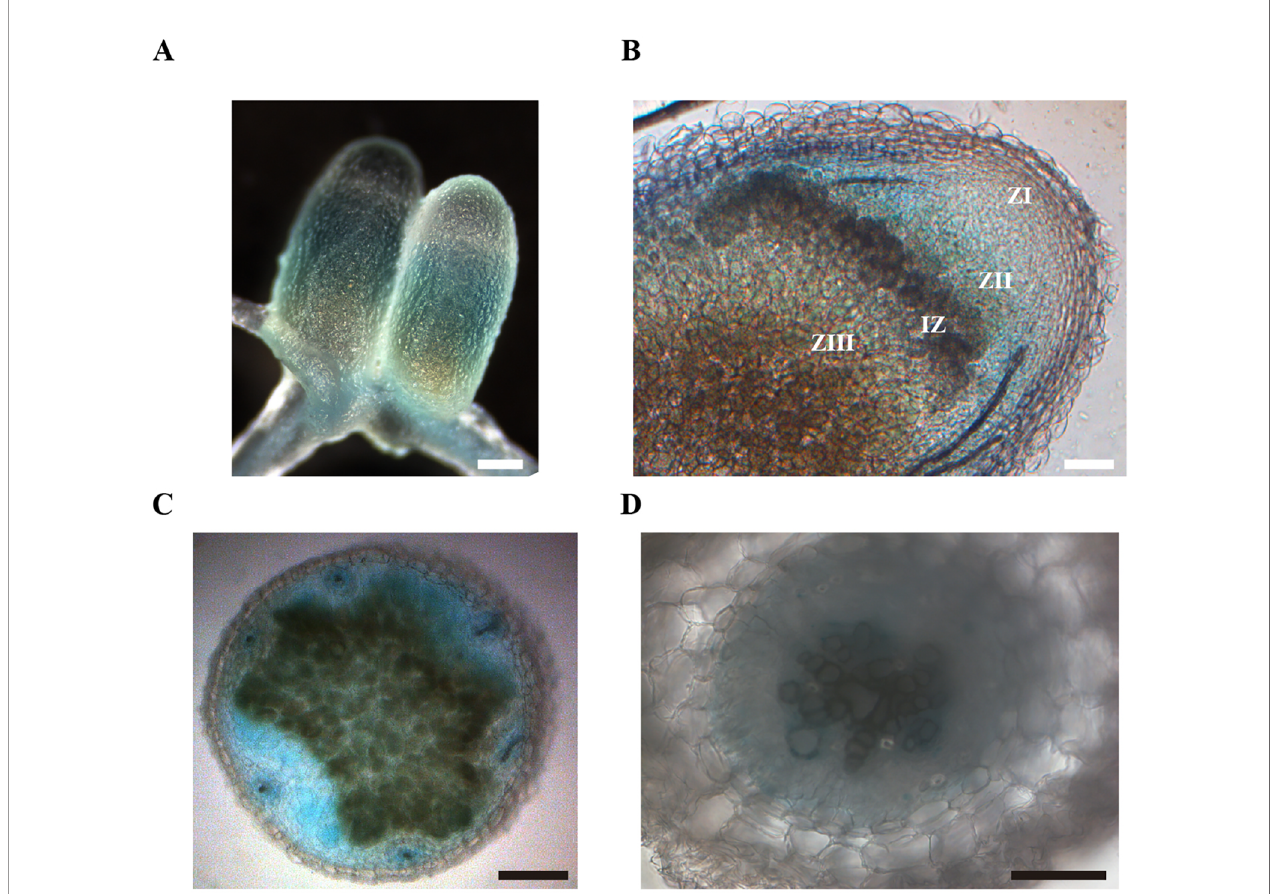
FIGURE 4 | MtNAS2 is expressed in the root vasculature and in the late zone II, interzone, zone III, and vessels in nodules. (A) b -glucuronidase (GUS) staining of 28 dpi Medicago truncatula roots and nodules expressing the gus gene under the control of MtNAS2 promoter region (n = 10 – 20 plants). Bar = 100 m m. (B) Longitudinal section of a GUS-stained 28 dpi M. truncatula nodule expressing the gus gene under the control of MtNAS2 promoter region (n = 30 sections from 10 to 20 plants). ZI indicates zone I; ZII, zone II; IZ, interzone; and ZIII, zone III. Bar = 100 m m. (C) Cross section of the fi xation zone of a GUS-stained 28 dpi M. truncatula nodule expressing the gus gene under the control of MtNAS2 promoter region (n = 30 sections from 10 to 20 plants). Bar = 200 m m. (D) Cross section of a GUS-stained 28 dpi M. truncatula root expressing the gus gene under the control of MtNAS2 promoter region (n = 30 sections from 10 to 20 plants). Bar = 100 m